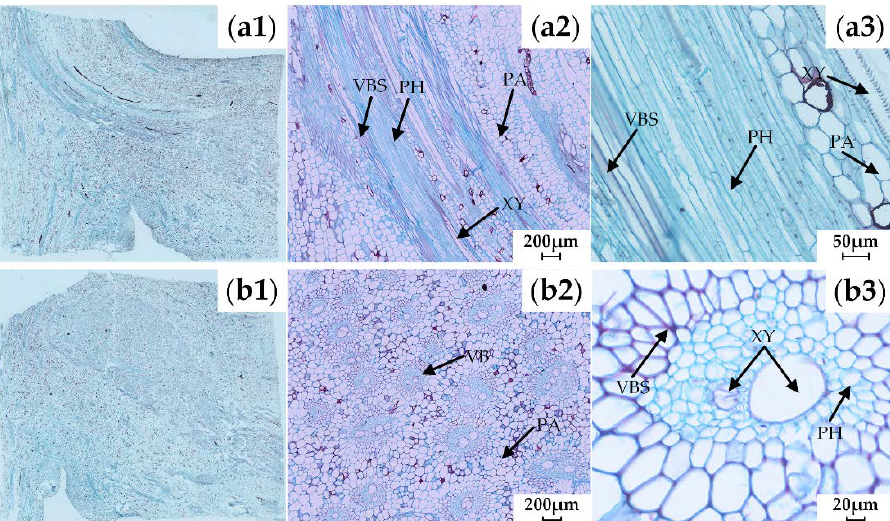
Figure 5. Longitudinal tissue sections of the crown. ( a1 ) Is the original paraffin-embedded tissue section image obtained at 20X magnification; ( a2 ) and ( a3 ) are the enlarged images of ( a1 ), respectively; ( b1 ) is the original paraffin-embedded tissue section image obtained at 20X magnification; ( b2 ) and ( b3 ) are the enlarged images of ( b1 ), respectively. PA = Parenchyma, PH = Phloem, VB = Vascular bundle, VBS = Vascular bundle sheath, XY = Xylem.